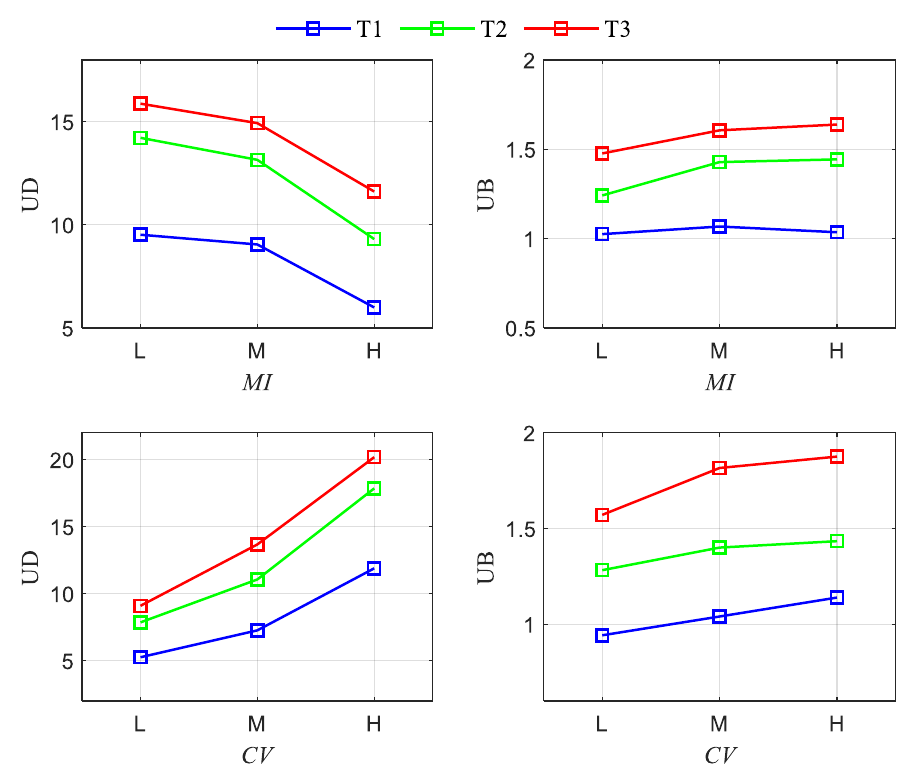
Figure 14. Relationship between radar rainfall uncertainty bands and rainfall temporal variability.